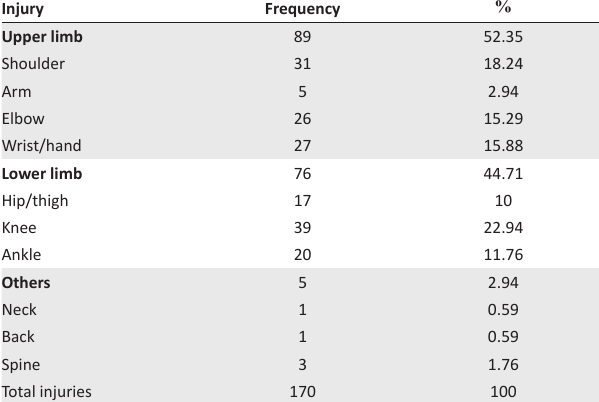
TAB LE 2: Pattern of injuries amongst the players ( n = 142).